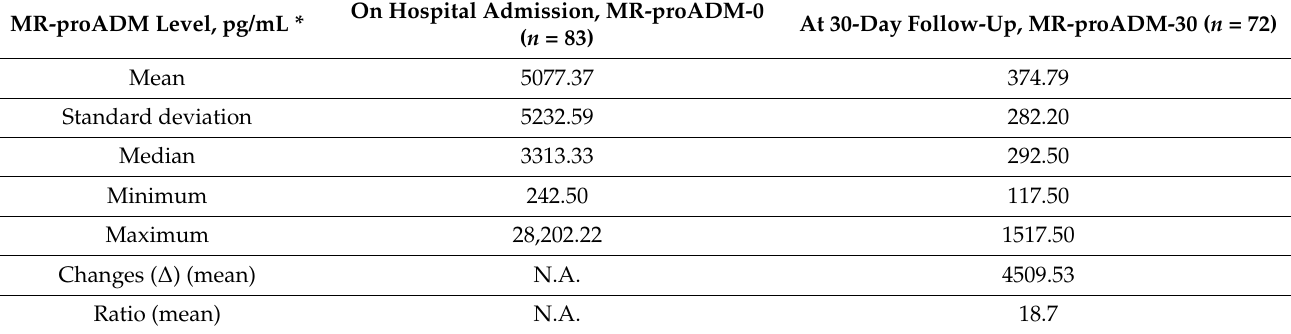
Table 2. The MR-proADM levels on hospital admission and at 30-day follow-up.